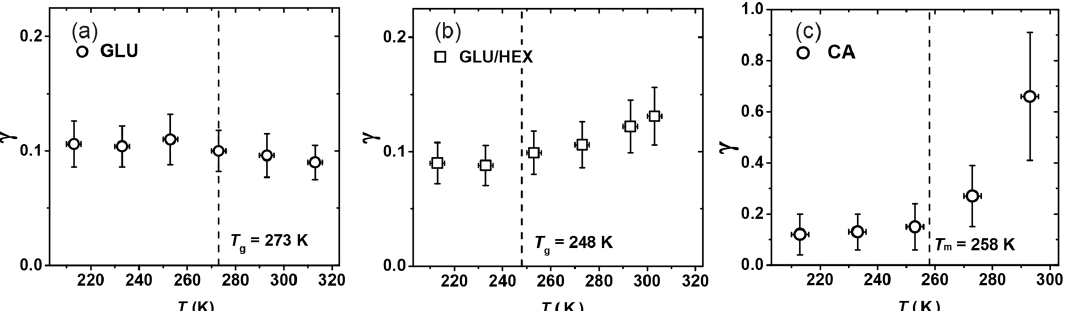
Figure 9. Reactive uptake coefficients, γ , of OH radicals reacting with (a) glucose (GLU), (b) 1 : 4 by mass glucose and 1,2,6-hexanetriol (GLU/HEX) mixture, and (c) canola oil (CA) as a function of temperature. T g is the glass transition temperature determined in the poke-flow